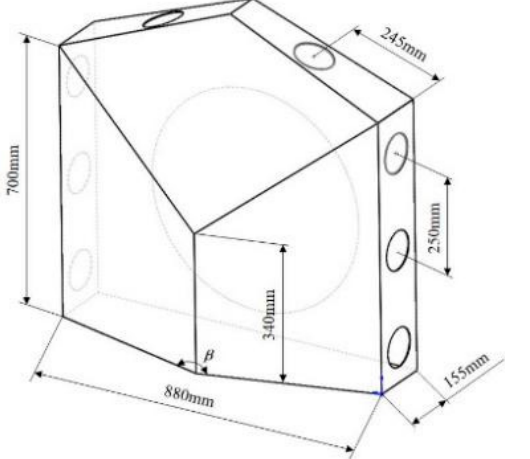
Figure 4. Diversion box size chart. The angle β is 150°, 160°, 170°, and 180°, respectively.